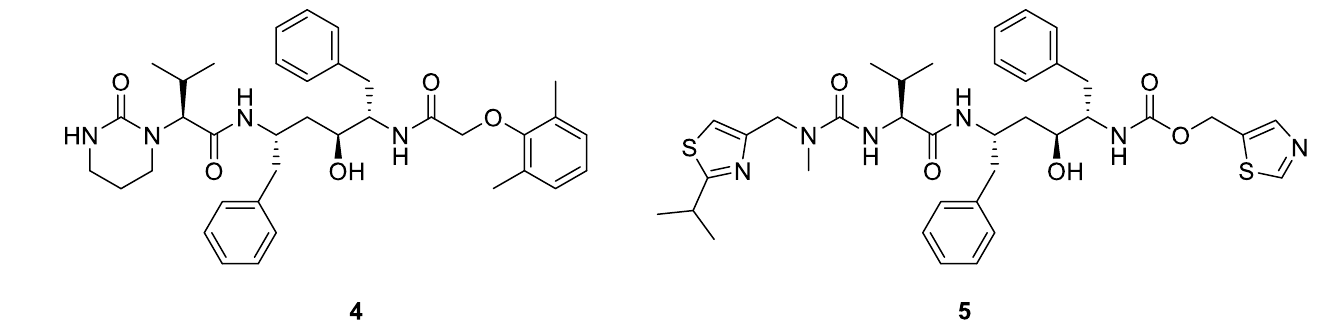
Figure 2. Chemical structure of lopinavir ( 4 ) and ritonavir ( 5 ).